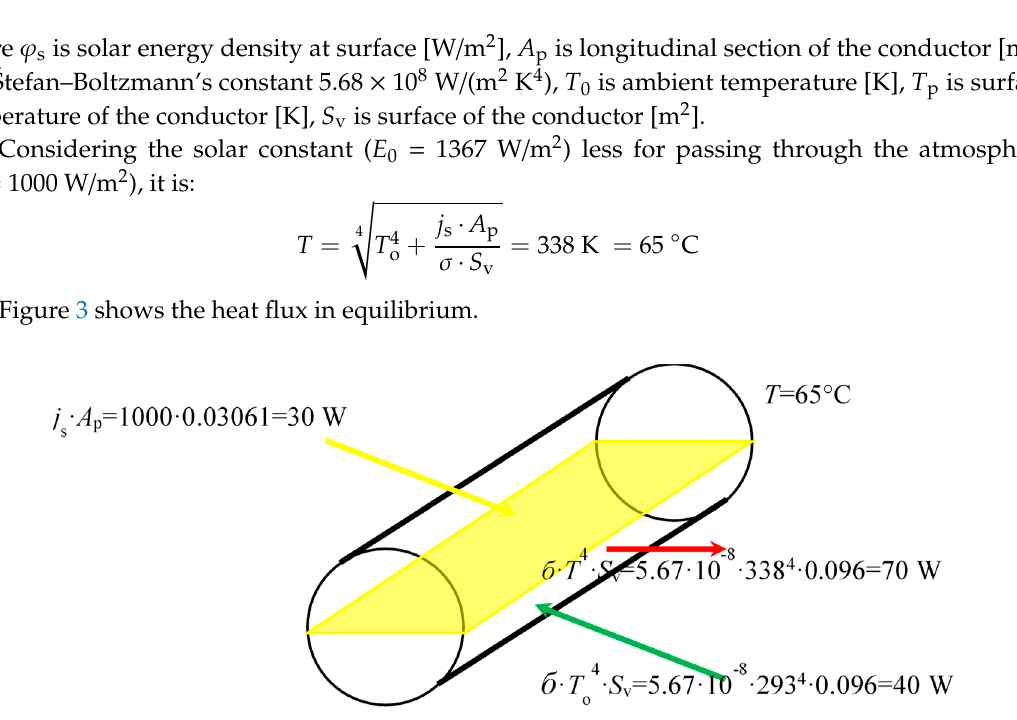
Figure 3. Thermal balance of the conductor in the sun. Note: sun = 30 W, surrounding = 40 W, conductor at 65 °C = 70 W.